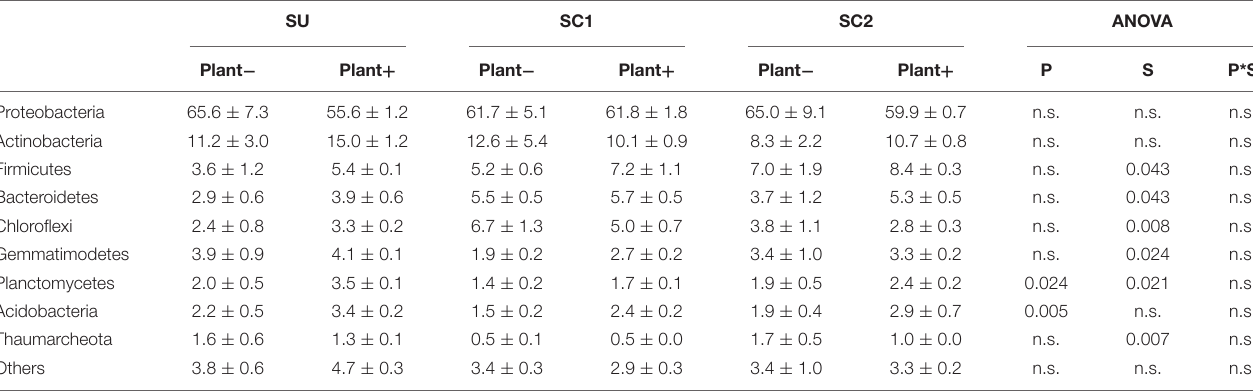
TABLE 2 | Relative abundances (%) and standard errors of the most abundant bacterial phyla in the three soils (SU, unamended soil; SC1, soil amended with compost 1; SC2, soil amended with compost 2), with (plant + ) or without (plant − ) olive sapling plant. SU SC1 SC2